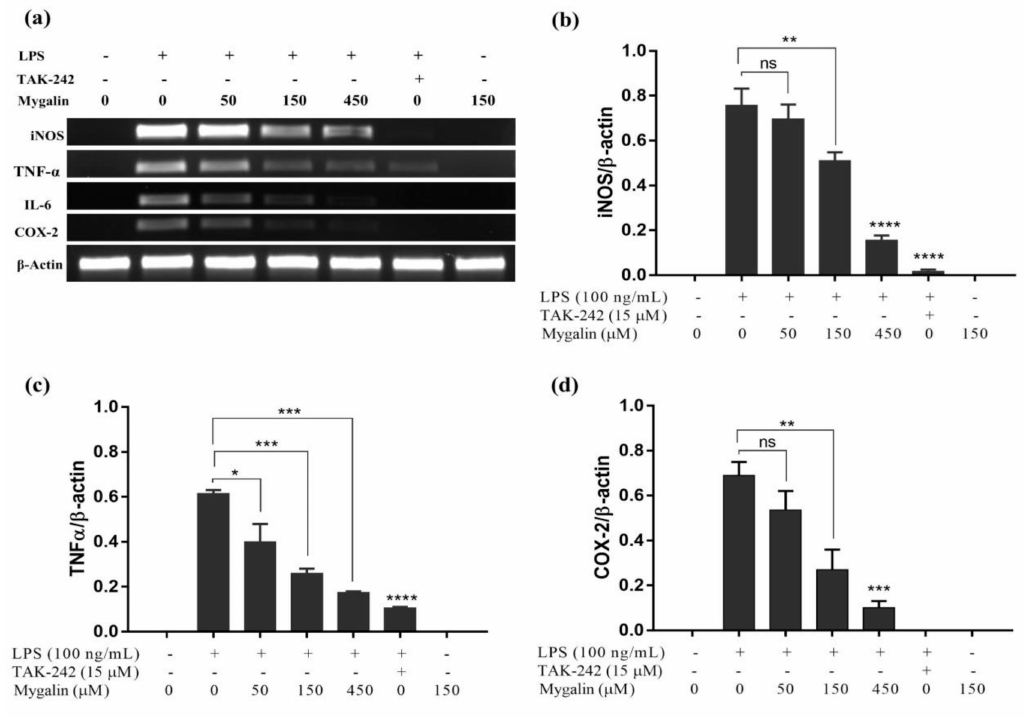
Figure 4. Mygalin inhibits the mRNA expression levels of iNOS, TNF- α , and COX-2 in RAW cells stimulated with LPS. Cells were pretreated with mygalin for 1 h and then stimulated with LPS for 6